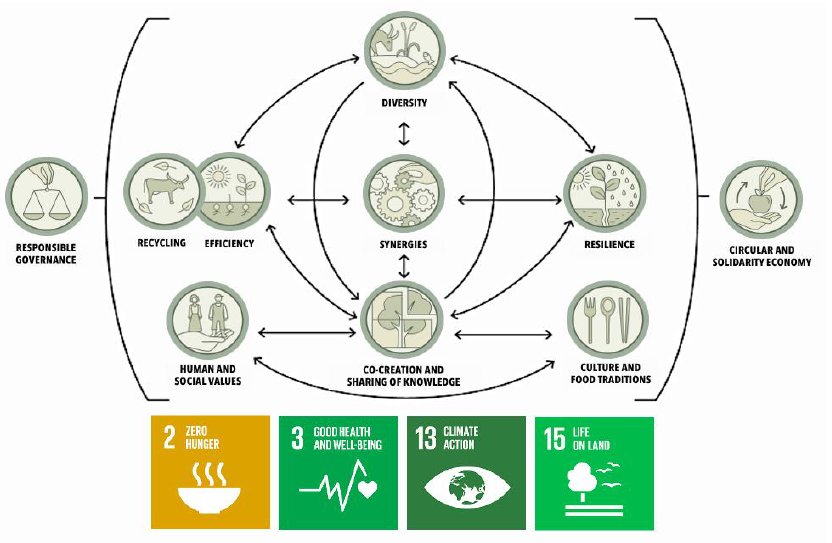
Figure 1. The ten interlinked and interdependent elements of agroecology that guide countries to transform their agricultural systems and to achieve multiple Sustainable Development Goals (SDGs), notably SDG2, SDG3, SDG13, and SDG15. (Adapted with permission from Food and Agriculture Organization of the United Nations (2018) FAO).